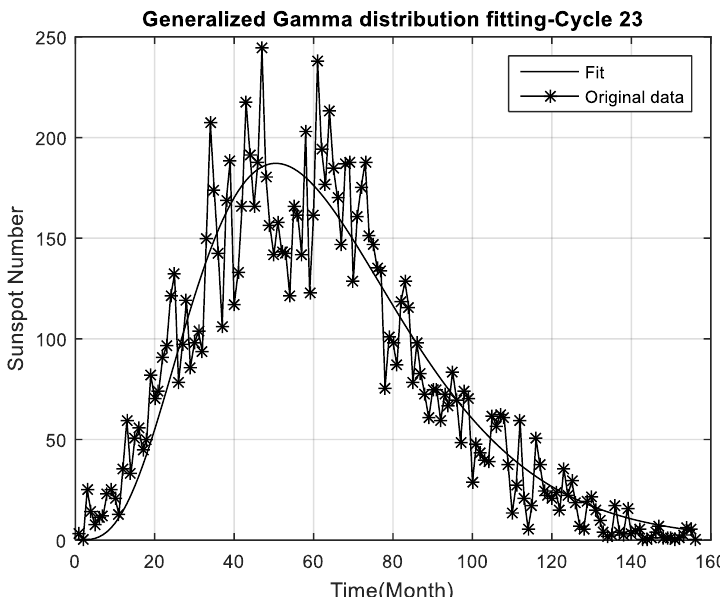
Figure 2. Generalized Gamma distribution fit on the monthly averaged sunspot number cycle